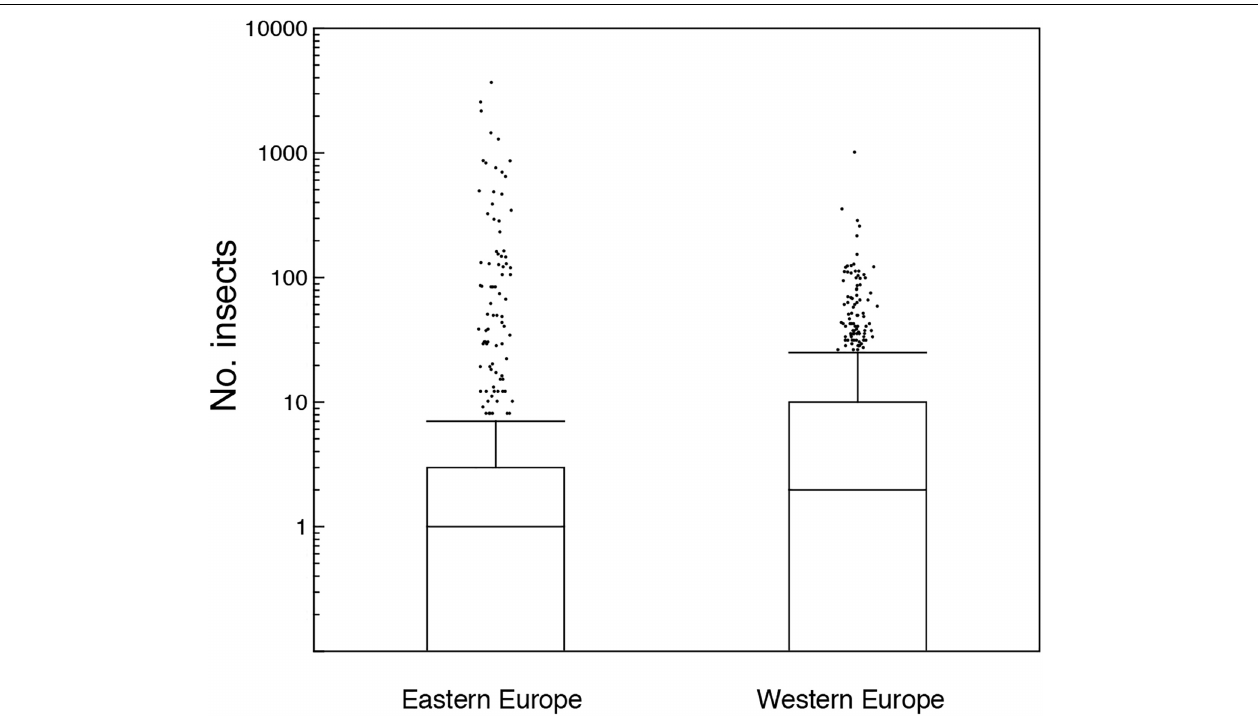
FIGURE 2 | Box plots of the number of insect sampled with a car in Eastern and Western Europe. The box plots show median, quartiles, 5- and 95-percentiles and extreme values. Observations are jittered to make observations visible.